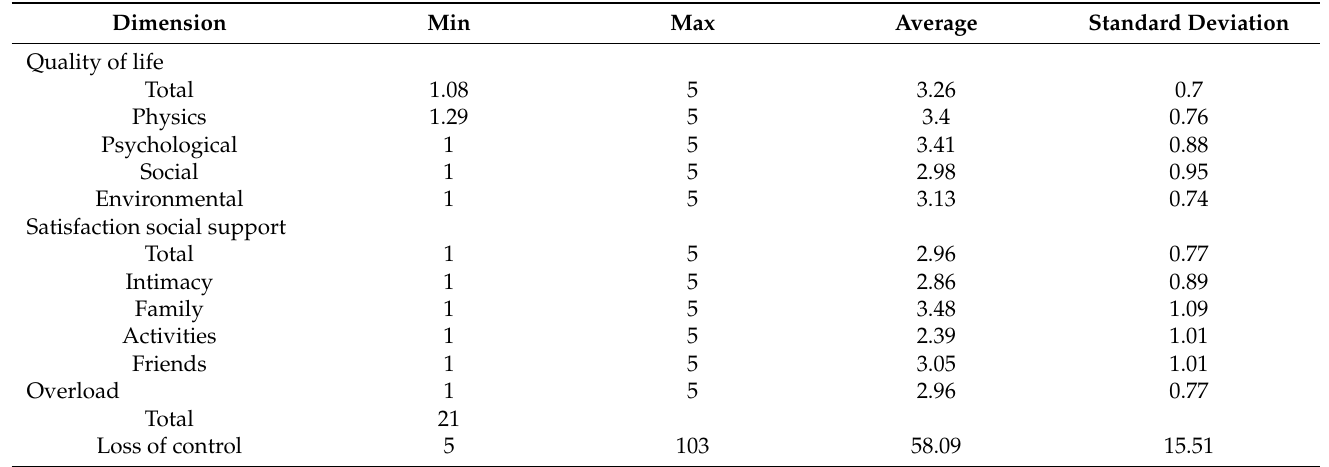
Table 3. Descriptive results of the psychological variables under